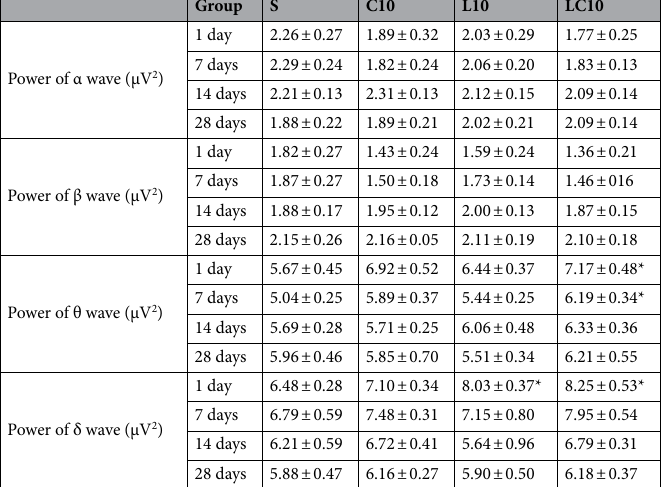
Table 3. Alterations in electroencephalography (EEG) in rats at 7 days, 14 days and 28 days after microwave irradiation and changes in the frequencies of α, β, θ, and δ wave power (n = 5). Data were shown as the mean ± SE. *P < 0.05 vs. sham. The data in the table were analyzed by SPSS 22.0.